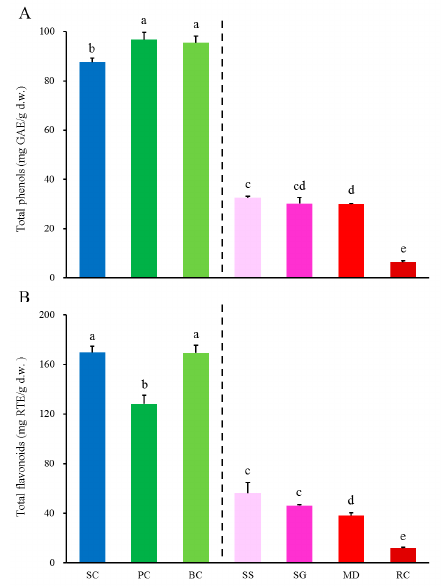
Figure 1. Total phenols ( A ) and total flavonoids ( B ) of S. cuneata and its six adulterants. SC, PC, BC, SS, SG, MD, and RC were abbreviations of Sargentodoxa cuneata , Polygonum cuspidatum , Bauhinia championii , Schisandra sphenanthera , Schisandra grandiflora , Millettia dielsiana , and Rubia cordifolia in respective. Vertical lines provide hints that data on the left side are far greater than those on the right side. Different letters mean significant difference ( p > 0.05), and data are mean ± SD ( n = 3).